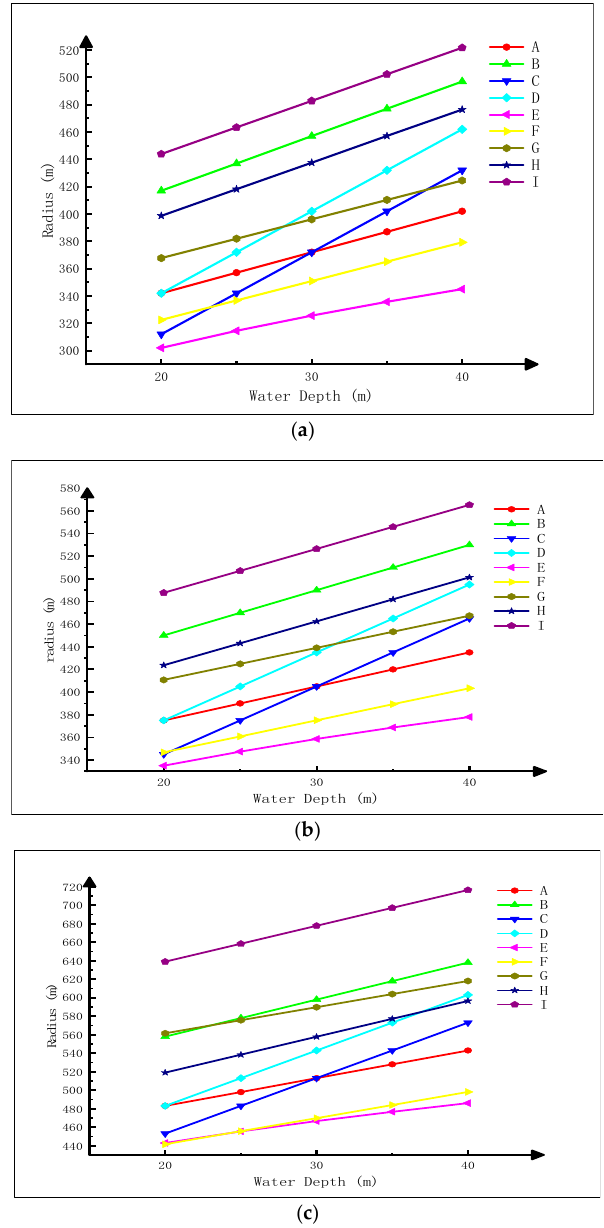
Figure 8. Schematic diagram of comparative analysis of the anchorage circle radius. ( a ) Schematic diagram of the anchorage circle radius of a 192 m general cargo ship. ( b ) Schematic diagram of the anchorage circle radius of a 225 m general cargo ship. ( c ) Schematic diagram of the anchorage circle radius of a 333 m general cargo ship.